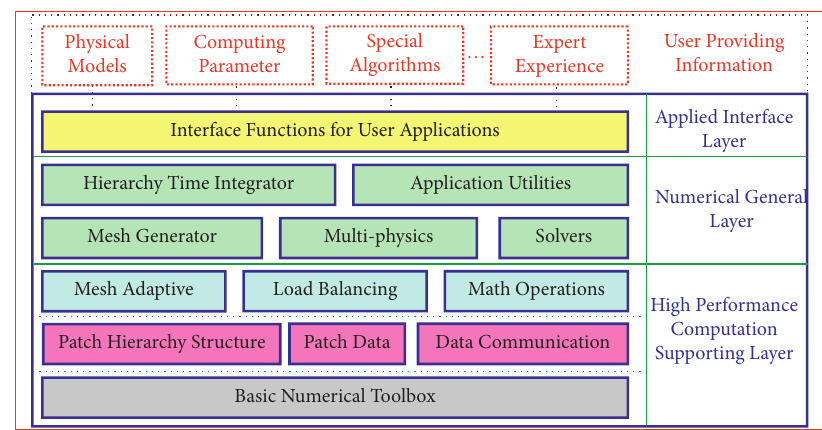
Figure 1: Architecture of the JAUMIN